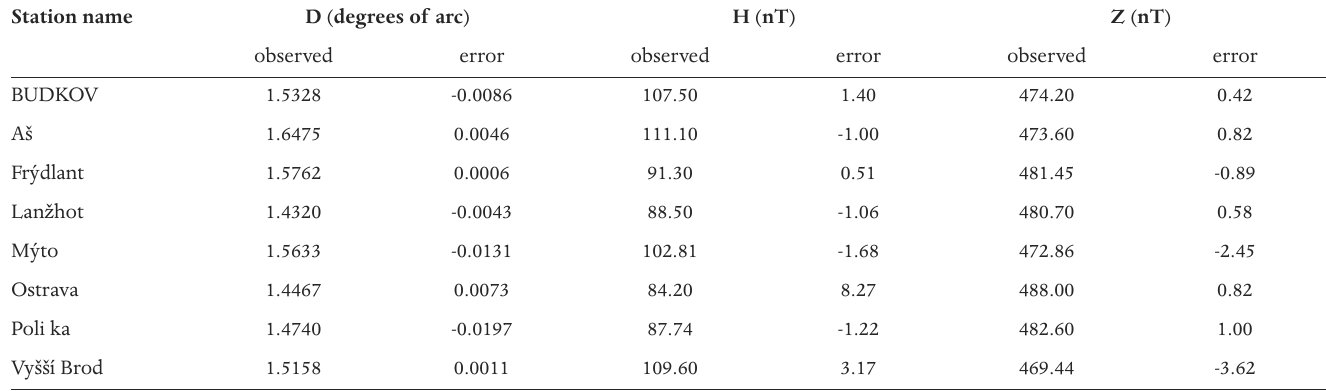
Figure 4. Linear model of secular variation between 1995.5 and 2010.5. Table 1 (below). Secular variation between 1995.5 and 2010.5 epochs and its linear model; error = observed_value -